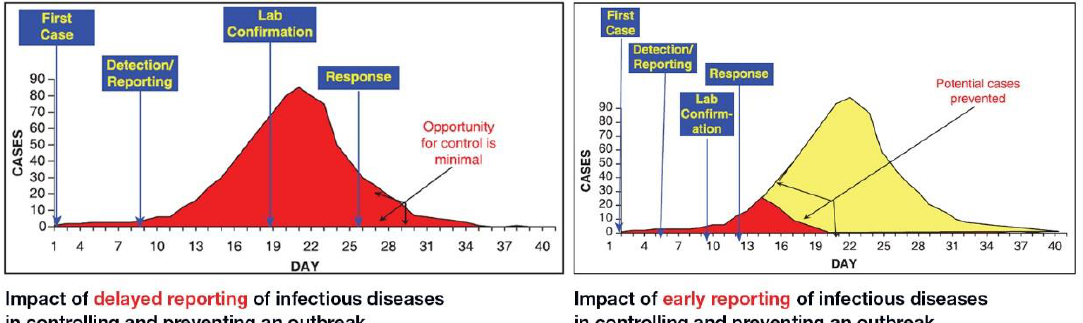
Figure 1. Importance of rapid testing of infectious diseases in controlling an outbreak. The y-axis represents the number of cases, and x-axis indicates the period of detection and response. The red color represents the number of cases without an intervention like testing, and yellow color is the drop in cases due to intervention, drastically reducing the response rate, unlike the graph on the left hand side [22].